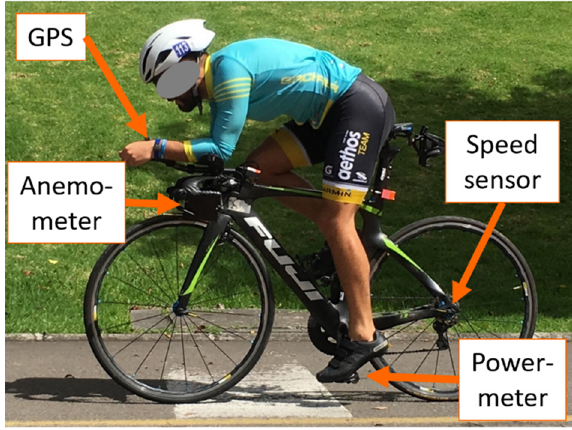
Figure 2. Setup for the characterization of the drag area and rolling resistance coefficient.